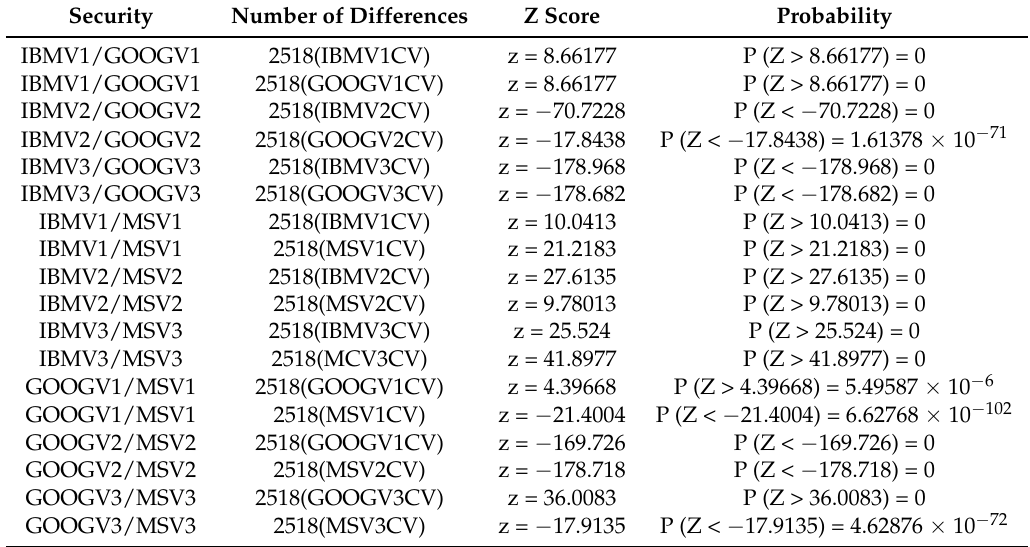
Table 8. Sign Tests of differences in the predicted conditional variances of DBEKK and FULL BEKK.